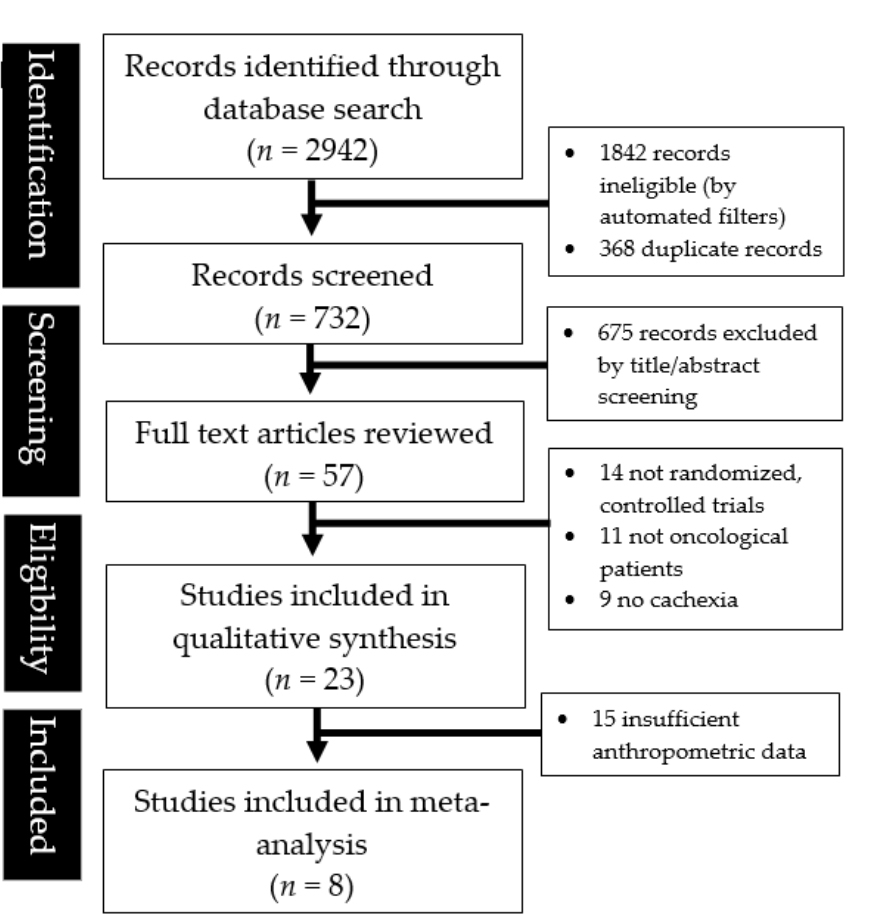
Figure 1. The PRISMA diagram illustrating the literature search and abstraction process.